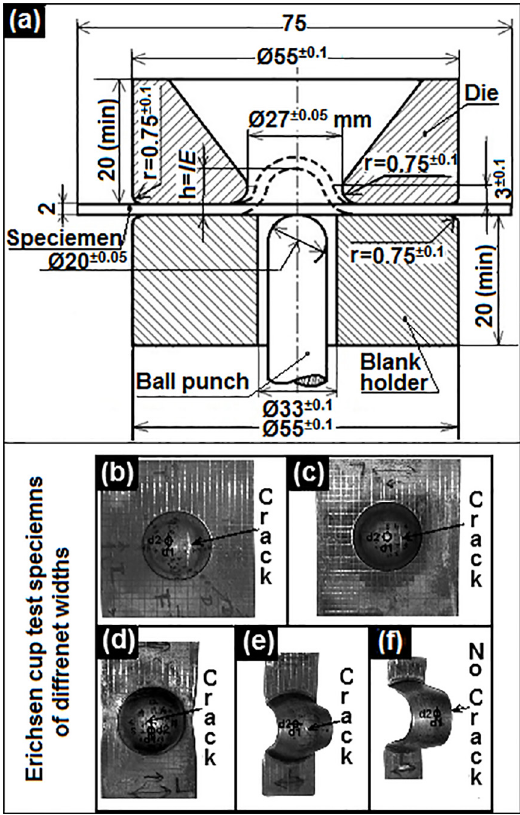
Figure 1. (a) Schematic showing of Erichsen cup test arrangements; (b-f) photo images of Erichsen cup specimens of different